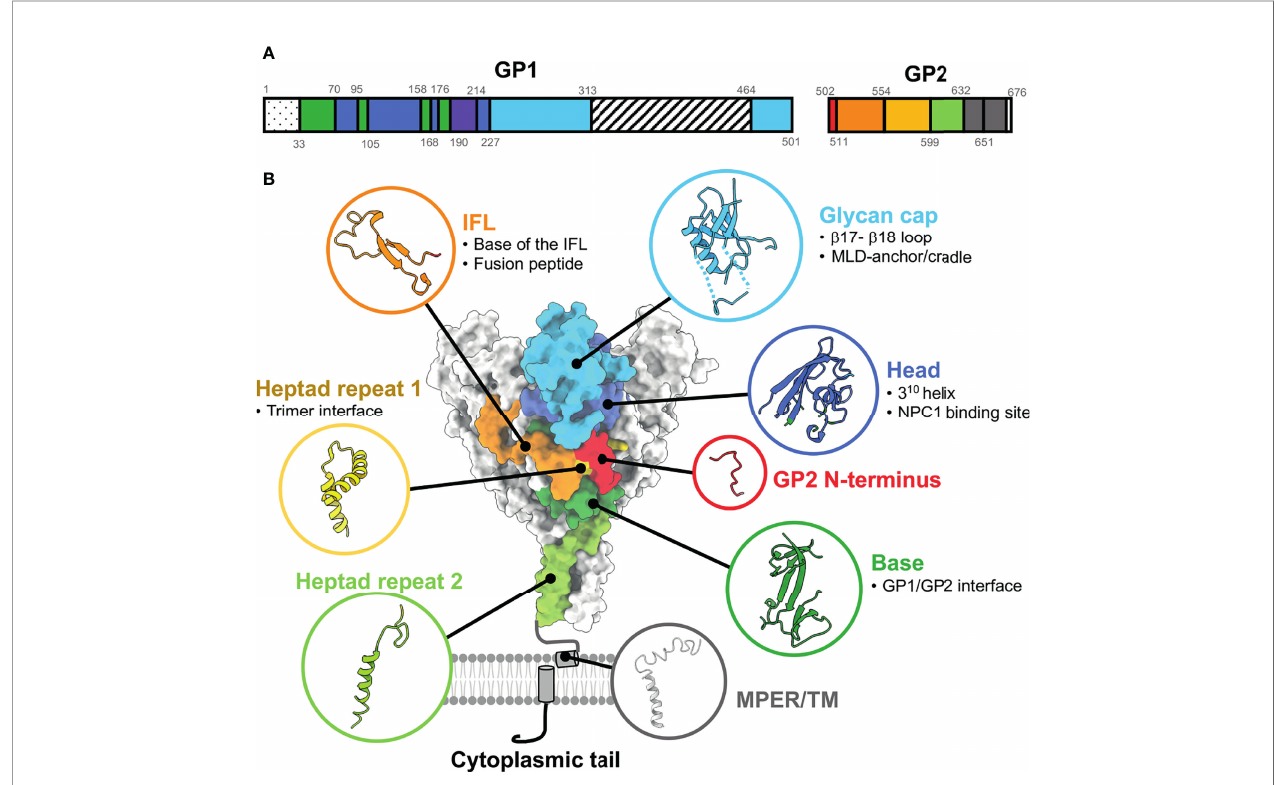
FIGURE 1 | Ebolavirus GP functional and antigenic domain structure. (A) Full-length EBOV GP gene schematic indicating domains determined from structural analysis by color. Residues encompassing each domain are indicated by numbers. The 1-33 dotted domain is the non-structural signal peptide. Residues 313-464 are the mucin- like domain (MLD), which is disordered. The purple region from residues 190-214 represents the cathepsin cleavage loop, which hangs over the internal fusion loop (IFL) and is loosely ordered. (B) Surface rendering of EBOV GP (PDBID: 5JQ3) with corresponding domains shown in ribbon [based on numbering in part A, from Lee et al. (41)]. Antigenic sub-domains are indicated in bullet points. NPC1, Nieman Pick C1; MPER, membrane-proximal external region; TM, transmembrane domain. The structure of the MPER/TM is from PDBID: